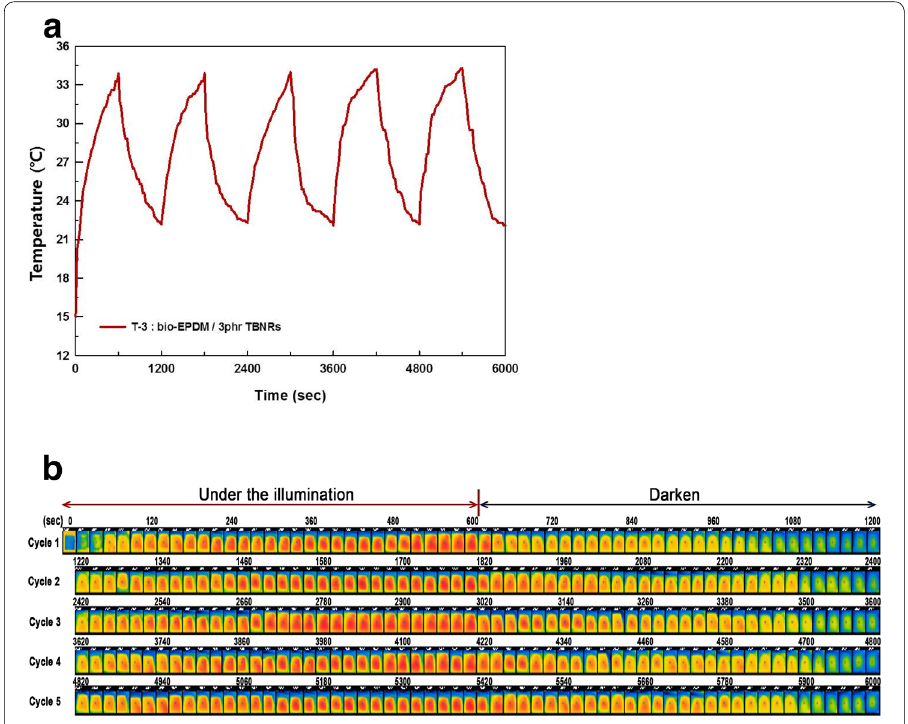
Fig. 8 Temperature variation profiles ( a ) and NIR images ( b ) of bio‑EPDM foam with TBNRs (T‑3) during five consecutive irradiation